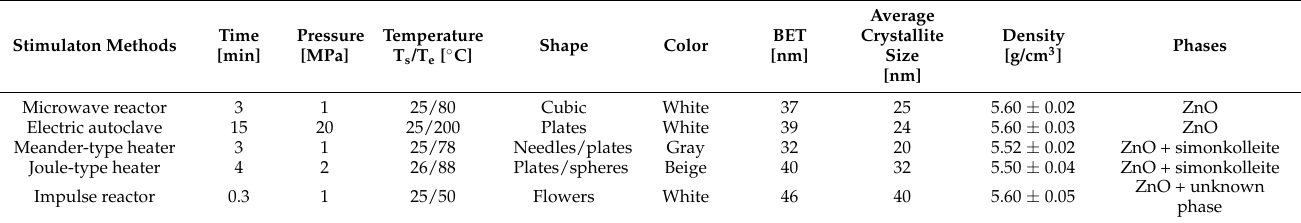
Table 1. Results of analyses the zinc oxide